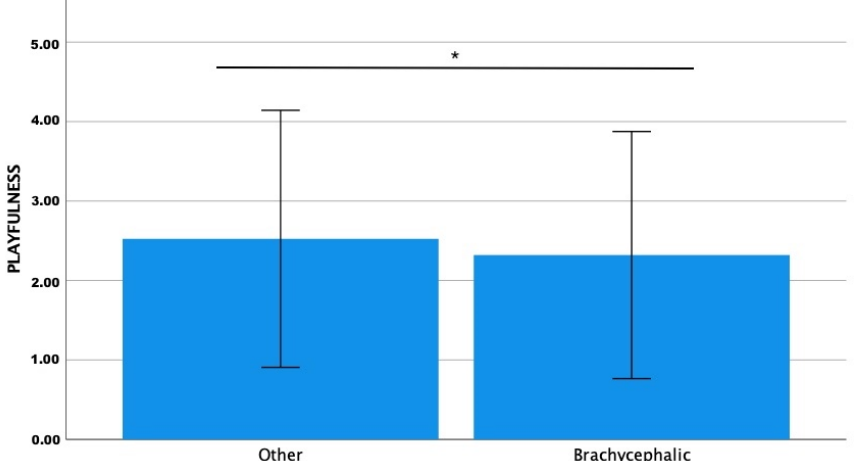
Figure 4. Comparison of Fe-BARQ mean scores for playfulness between brachycephalic and non- brachycephalic breeds. * p = 0.002.